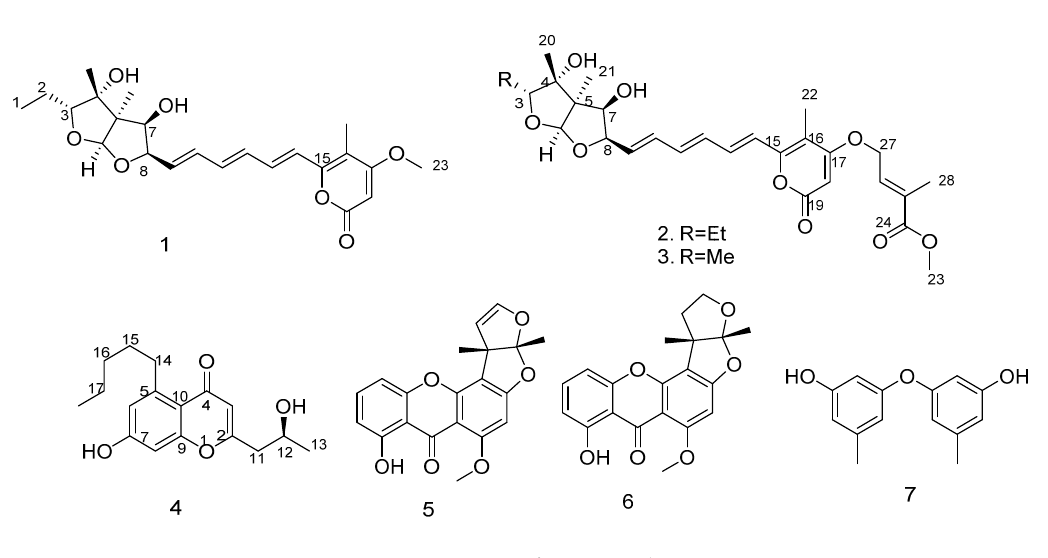
Figure 1. Structure of compounds 1 – 7 .